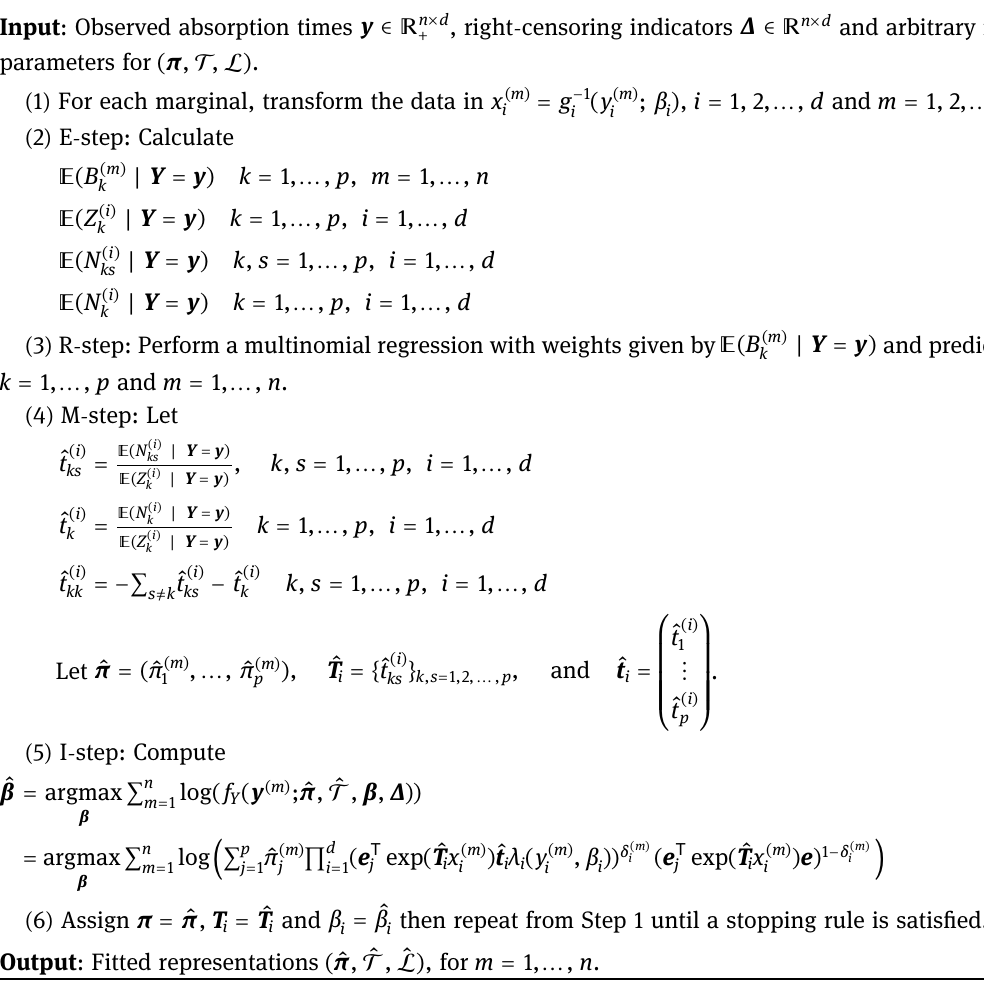
Algorithm 1. Adapted expectation maximization ( ERMI ) algorithm for mIPH